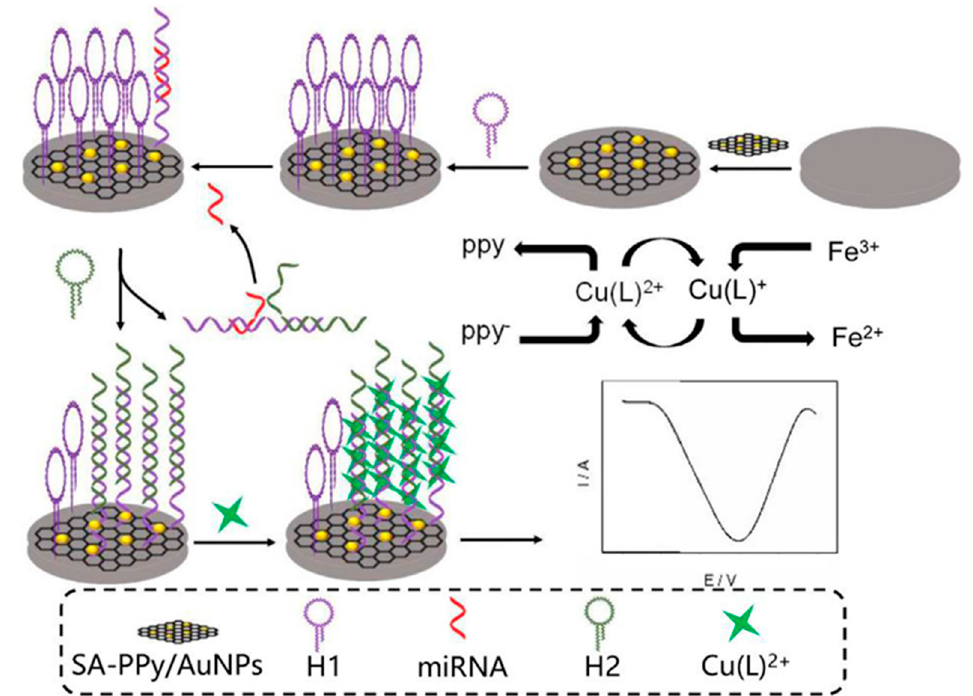
Figure 3. Scheme of the strategy for the electrochemical determination of miRNA-21 using a nanocomposite of sodium alginate-polypyrrole/Au nanoparticles (SA-PPy/AuNPs). Reproduced from [36] with